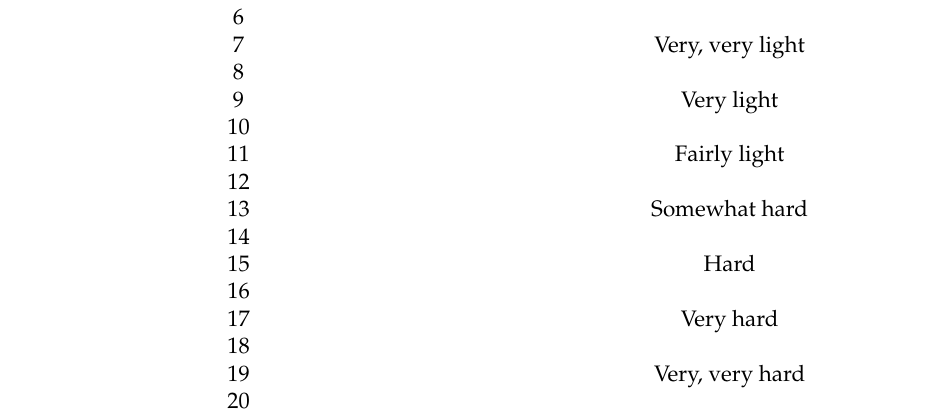
Table 2. Borg’s 15-grade scale for ratings of perceived exertion with values ranging from 6 to 20 (modified table according to Borg